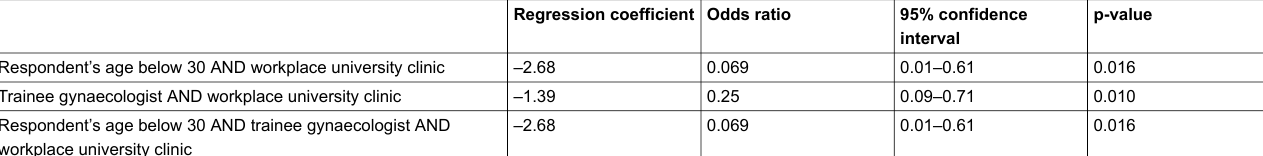
Table 3: Logistic regression analysis for prediction of the chance of initiating a bone-specific treatment combining two or three covariable. Regression coefficient Odds